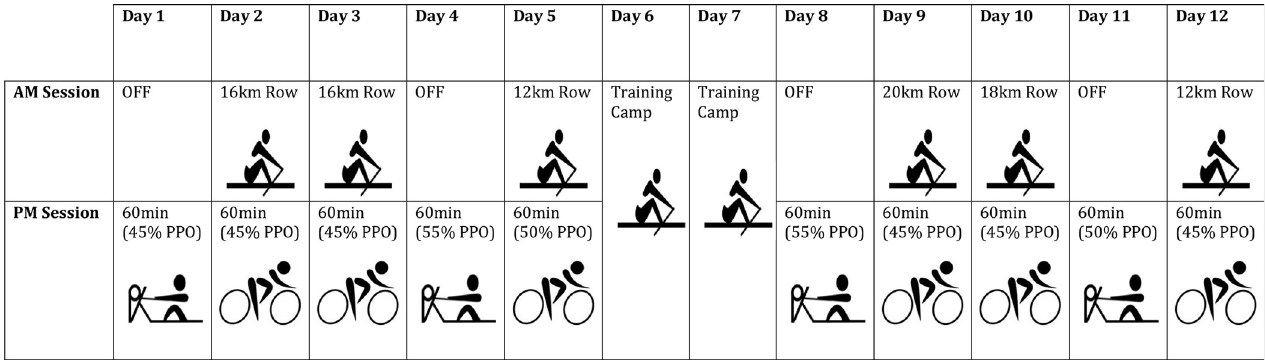
Fig 1. Schematic of training program during a 10-session heat acclimation intervention in national-level rowers. PPO: 4-min rowing ergometer time-trial average power output.